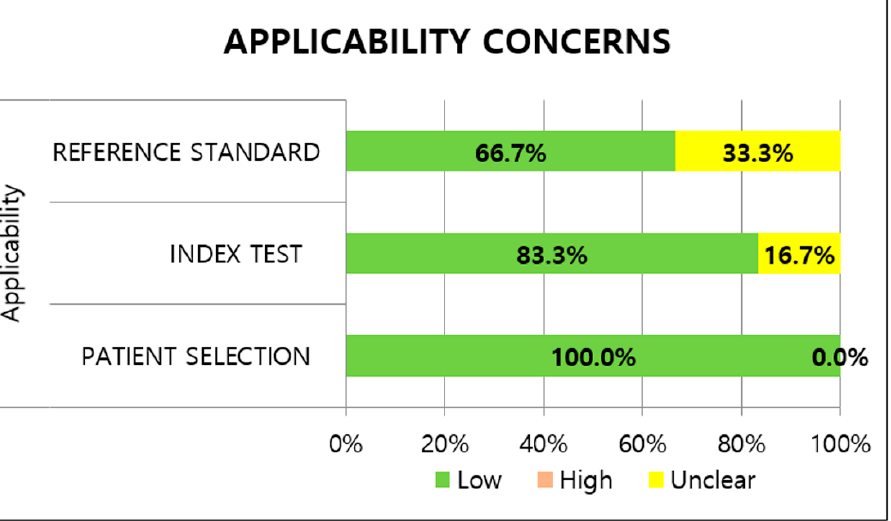
Figure 3. Methodological quality of included studies for applicability.